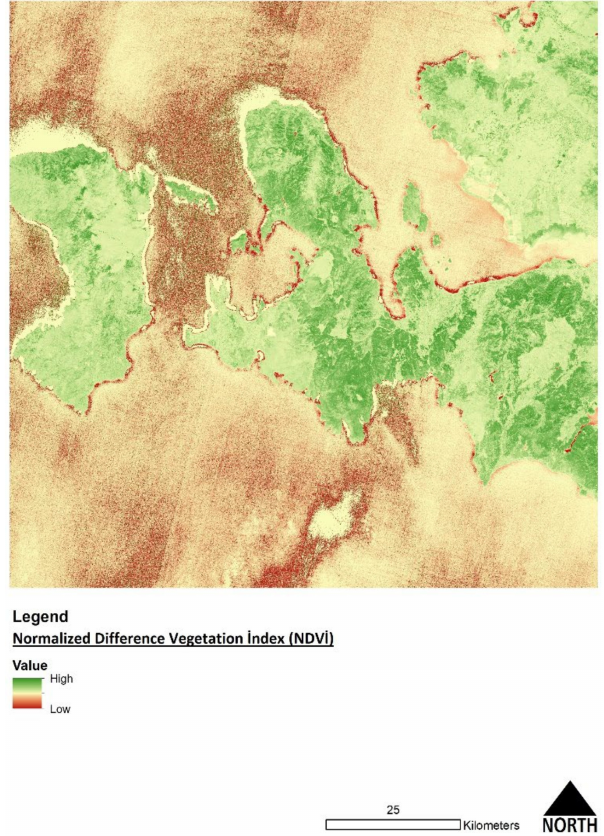
Figure 6. The Normalized Difference Vegetation